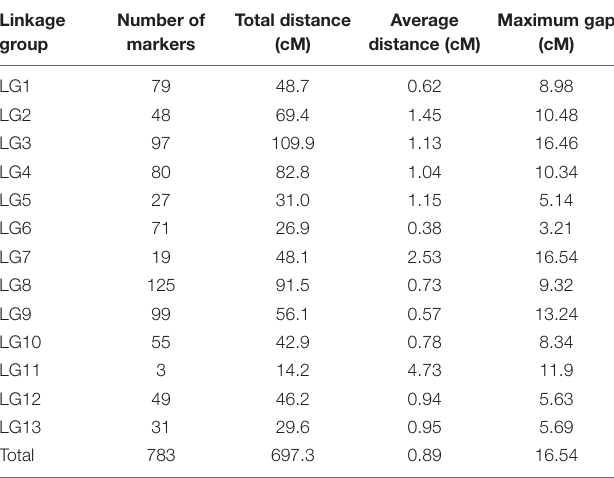
TABLE 4 | Basic characteristics of the 13 linkage groups.